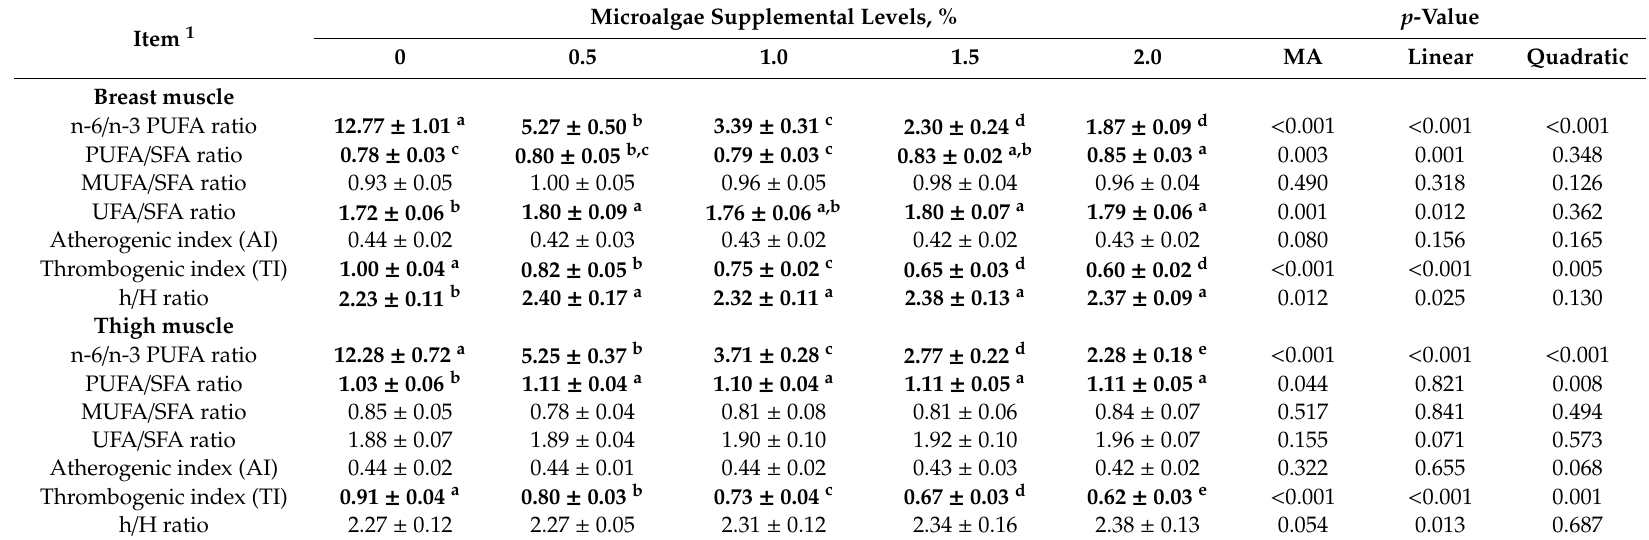
Table 5. Health lipid indices of fresh chicken meat from laying hens with graded levels of Aurantiochytrium sp.